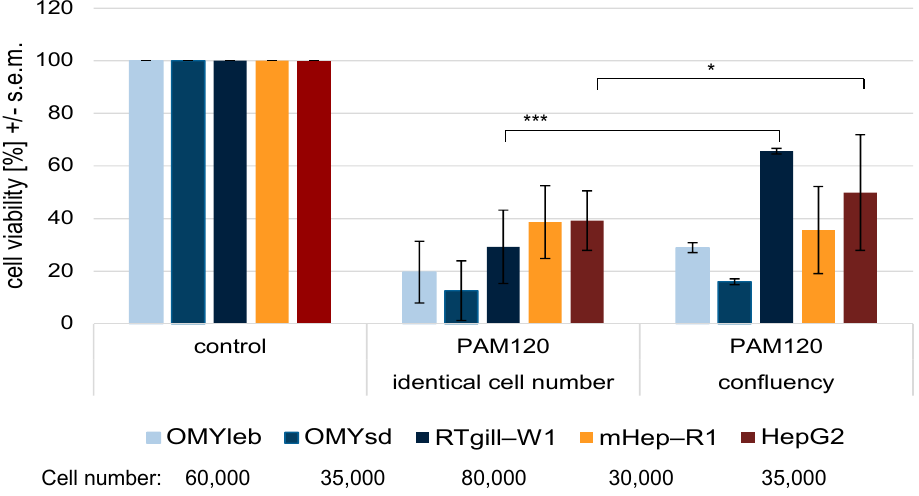
Figure 4. The influence of plasma treatment (PAM) on cell viability at different cell numbers. Fish and mammalian cells were seeded in different numbers (2 × 10 4 to 6 × 10 4 ) to reach the same degree of confluency (~80%) at the time of stimulation. The increase of cell number had a strong effect on RTgill-W1, but not on OMYsd cells. Cells were grown under identical medium conditions ( n = 3).